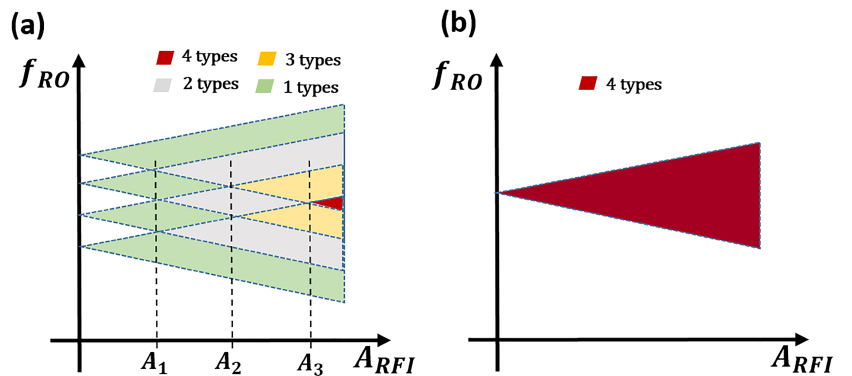
Figure 10. Immunity modeling and comparison of the RO-based TRNG. ( a ) Locking cones staggering with gate-delay differentiation; ( b ) locking cones overlapping without gate-delay